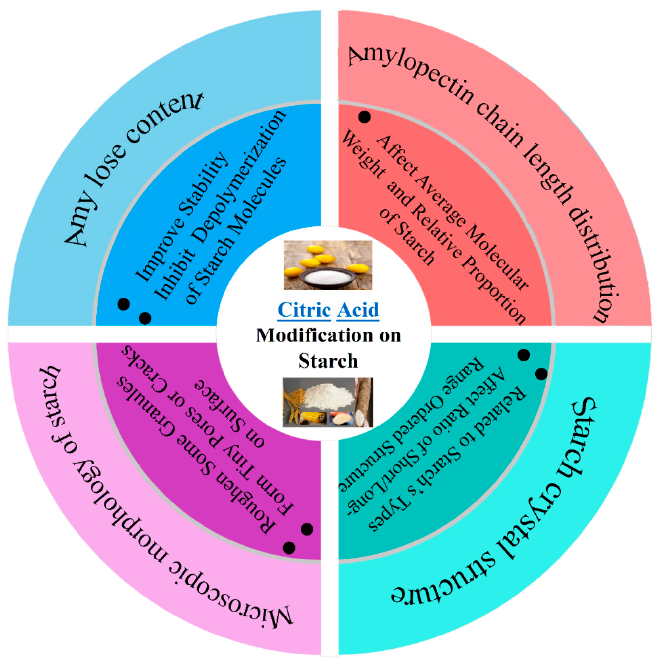
Figure 3. The effect of CA modification on the starch composition and structure.